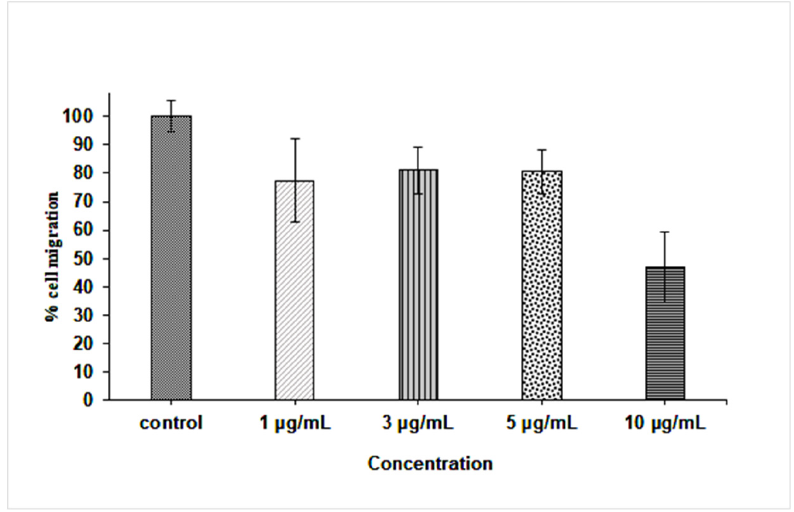
Figure 9. Percentage of fibroblast cell migration after 24 h treatment with 0, 1, 3, 5, and 10 µ g/mL AgNPs.